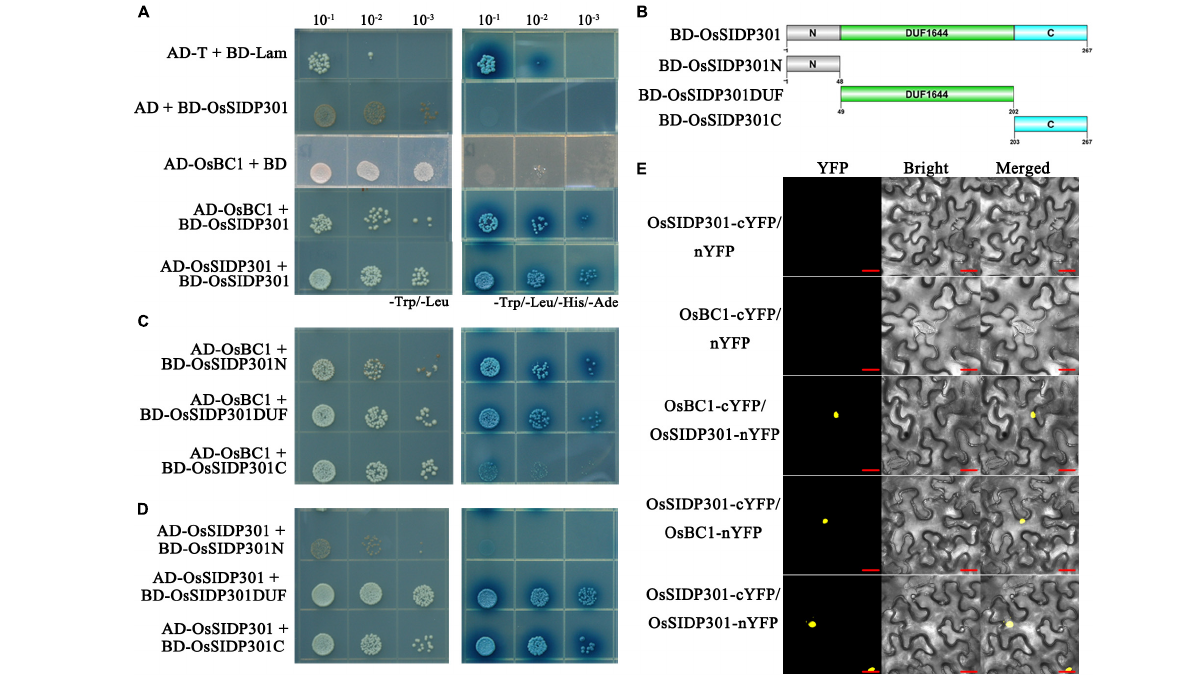
Frontiers in Plant Science |